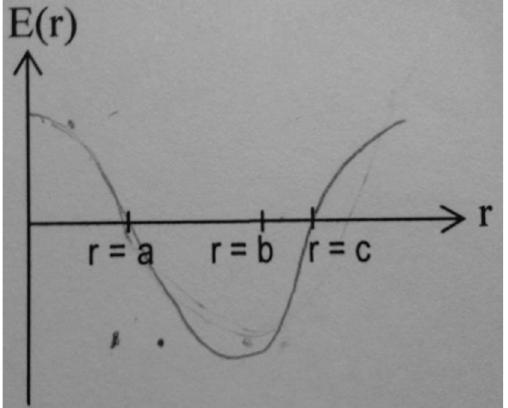
FIG. 6. Electric field plotted by Yara (an interviewed